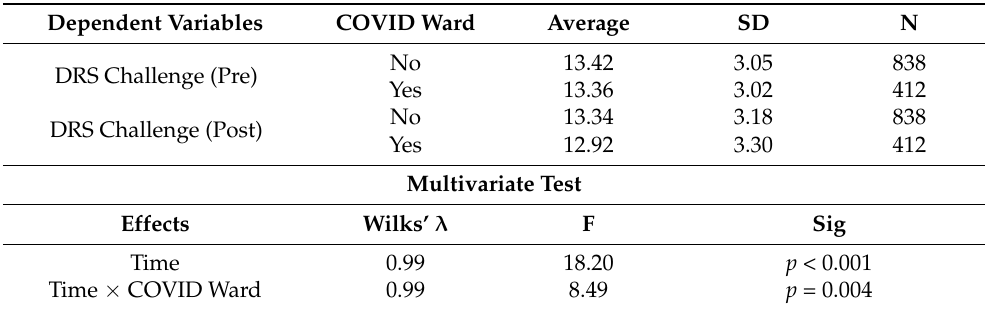
Table 8. Repeated measures ANOVA model of time (i.e., pre- and post-pandemic first-wave effect) and ward effects on DRS challenge. The model assesses the impact of the first wave of COVID-19 on resilience for nurses directly involved in caring for COVID-19 patients and on those who did not. Dependent Variables COVID Ward Average SD N